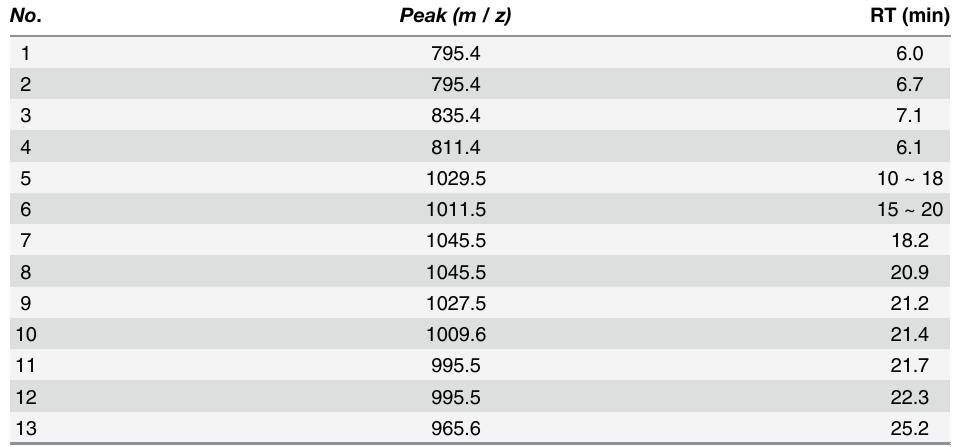
Table 2. Reaction intermediates of MCLR degraded by the combined UV/H 2 O 2